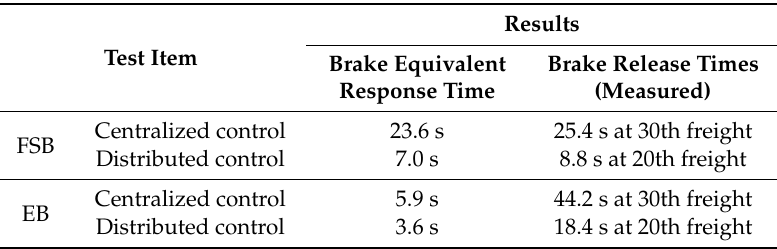
Table 2. Braking test